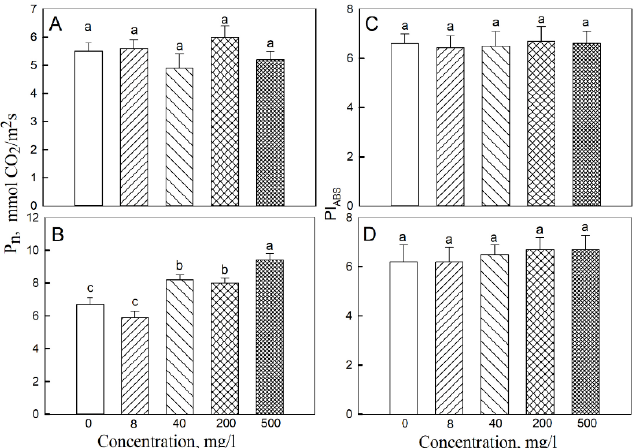
Figure 2. Effects of seed treatment with various concentrations of Fe 3 O 4 nanoparticles on the rate of CO 2 assimilation (P n ) and PSII productivity index (PI ABS ) in ( A , C ) second and ( B , D ) third leaves of 19-day-old wheat plants grown at a light intensity of 300 µ mol (photons) m − 2 · s − 1 . Data are means ± SD ( n = 5). Data labelled with different lower-case letters are significantly different at p < 0.05.